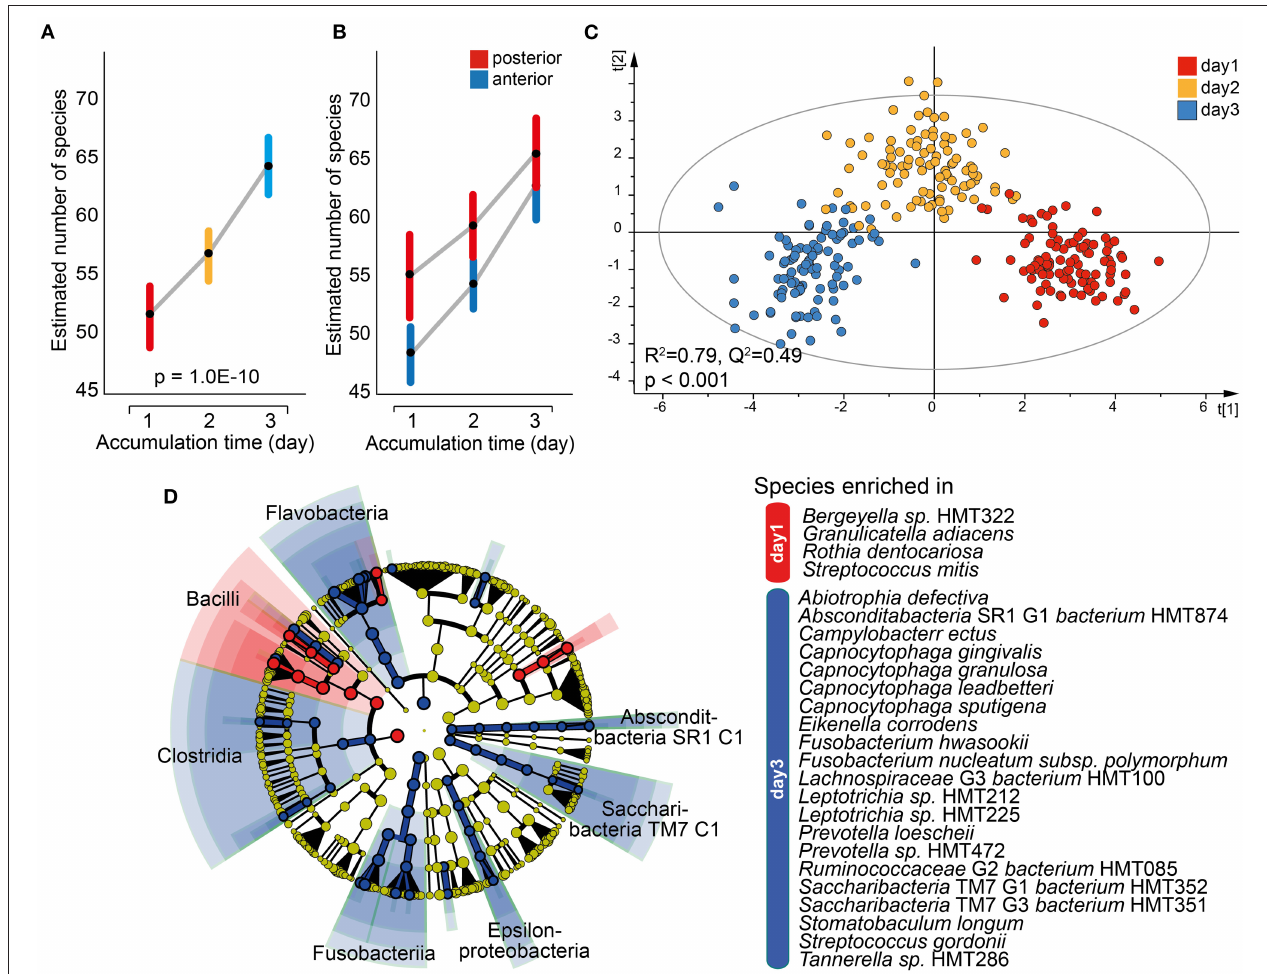
FIGURE 6 | Characterization of the tooth biofilm microbiota by increasing accumulation time. Mixed linear model of individual tooth biofilm samples at each accumulation time for (A) all samples or (B) anterior (incisor, canine) and posterior (premolar, molar) regions separately. Data are presented as estimated marginal means with 95% CIs. (C) Multivariate OPLS-DA modeling of the tooth biofilm microbiota composition collected after 1, 2, or 3 days without oral hygiene, illustrating the separation by accumulation time using discrimination components t [1] and t [2]. (D) Linear discriminant analysis (LDA) effect size analysis (LeFSe) derived phylogenetic differences associated with biofilm maturation and species differing between the three accumulation times (LDA score > 2.0 and p < 0.0043, Kruskal–Wallis test, comparing all against all